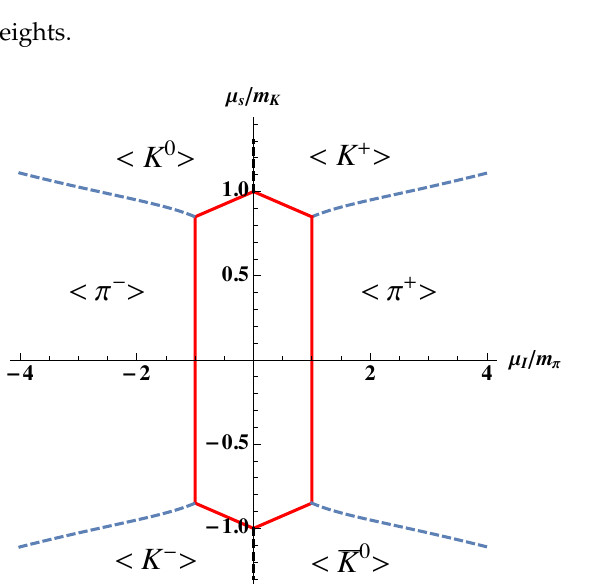
Figure 5. Phase diagram of the meson condensed phase, see [11]. The irregular hexagon (solid red line), obtained from the meson mass spectrum, corresponds to the second order phase transitions between the normal phase and the meson condensed phases. The dashed lines have been drawn by hand and represent the expected first order phase transitions between two different meson condensed